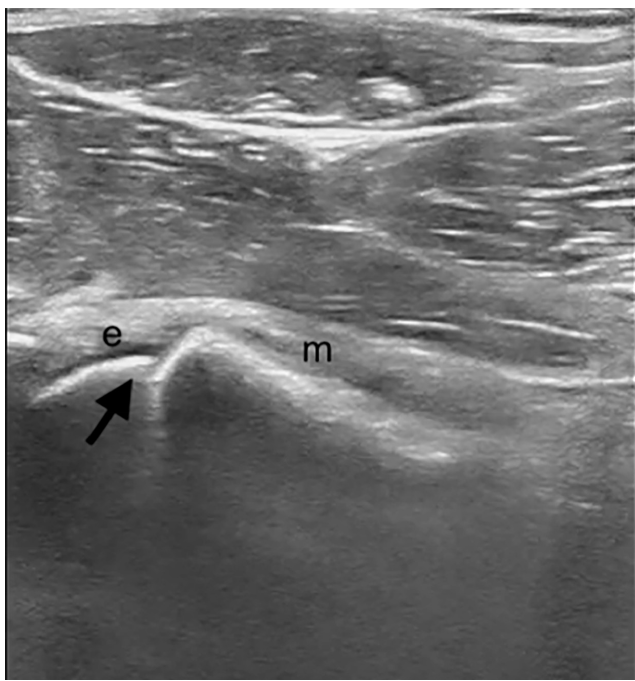
Image 1. Point-of-care ultrasound image of left hip showing displacement of epiphysis(e) from metaphysis (m) – the physeal step (arrow).